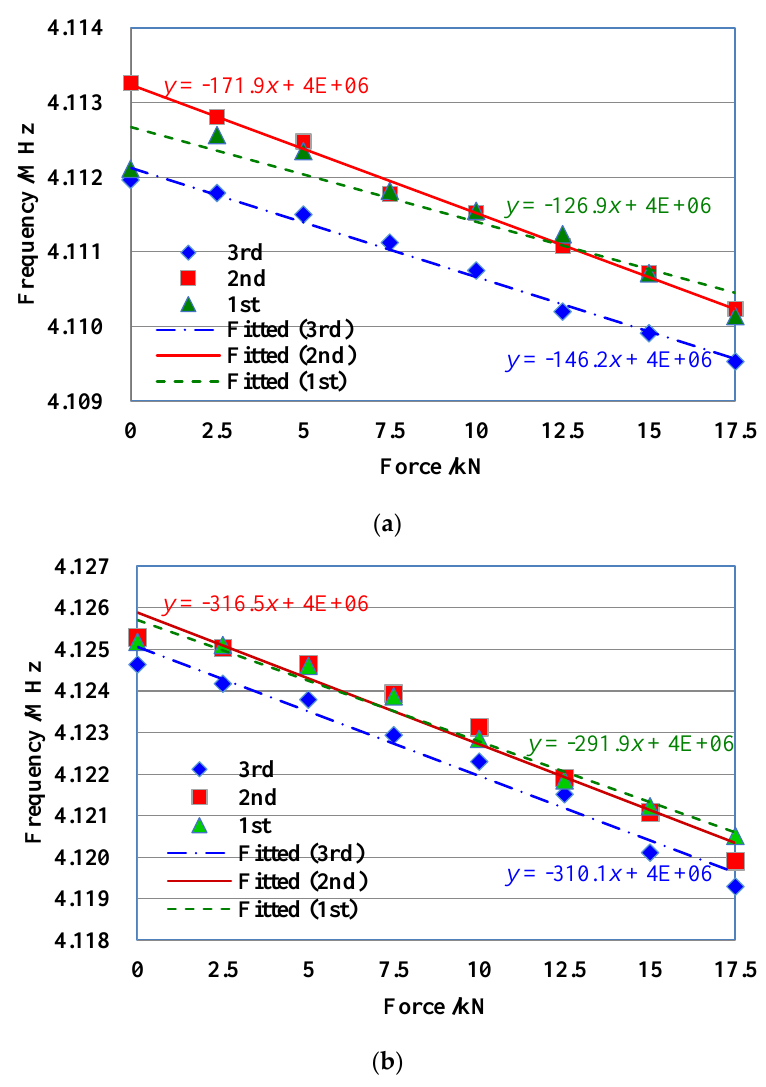
Figure 8. Admittance peak frequency changes with different bolt load for the M12 bolt. ( a ) Real part; ( b ) Imaginary part.